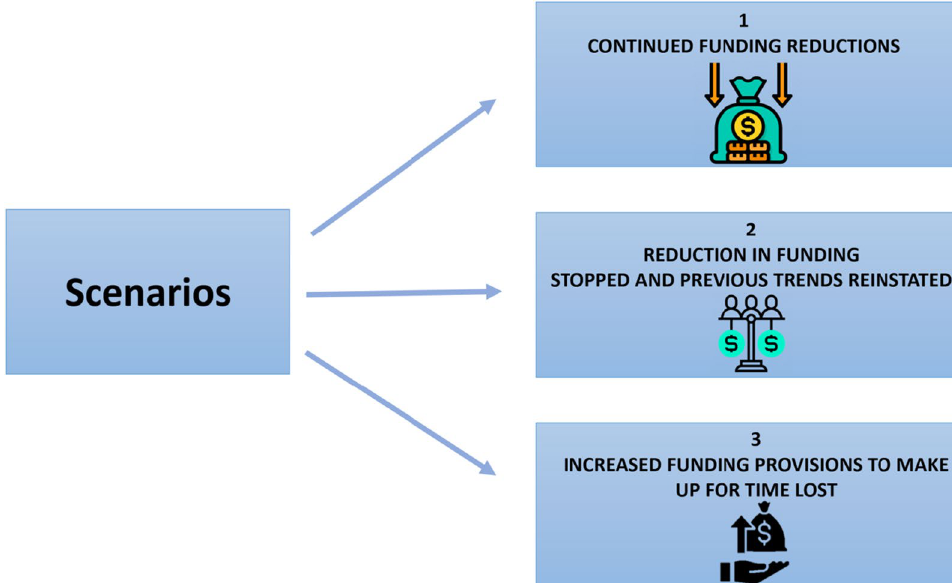
Fig. 6 Possible scenarios associated with funding to climate change in connection with the